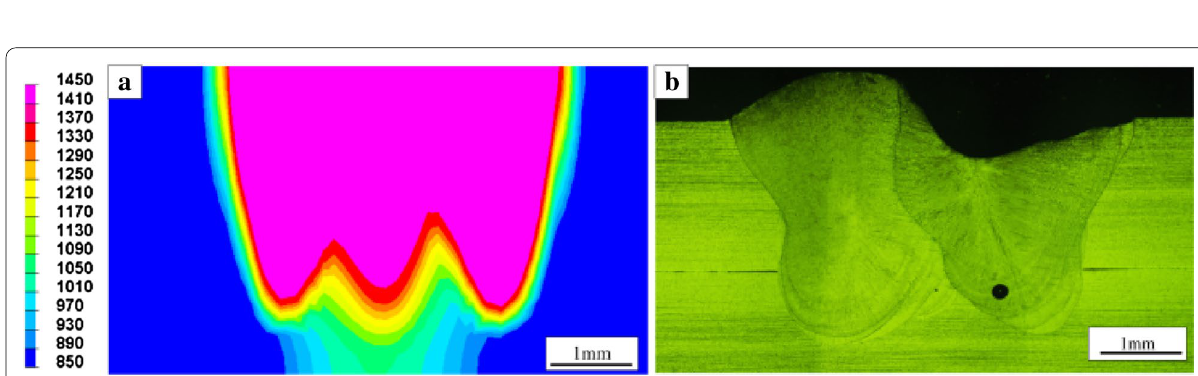
Figure 17 Welding method is 6-sections of joint morphology: a Numerical simulation of molten pool morphology; b Actual welded joint morphology